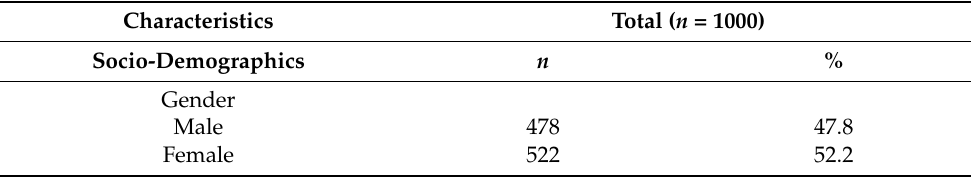
Table 1. General characteristics of the study